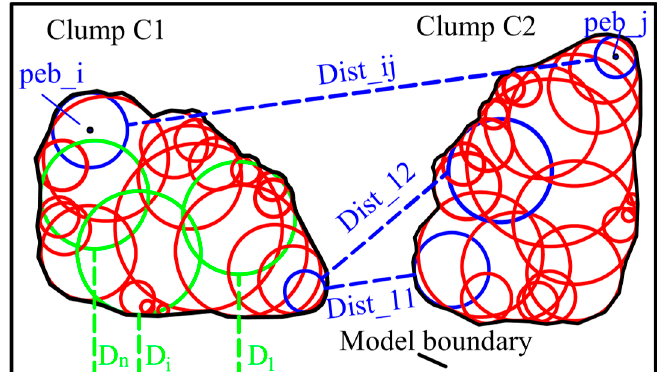
Figure 10. Schematic diagram of distance calculation method.